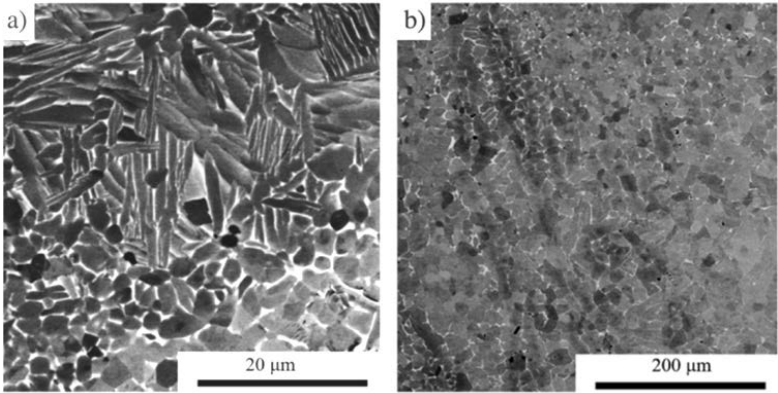
Figure 13. Backscattered electron micrographs of the swarf wire ( a ) before and ( b ) after heat treatment of wire containing extruded Ti-6Al-4V swarf.